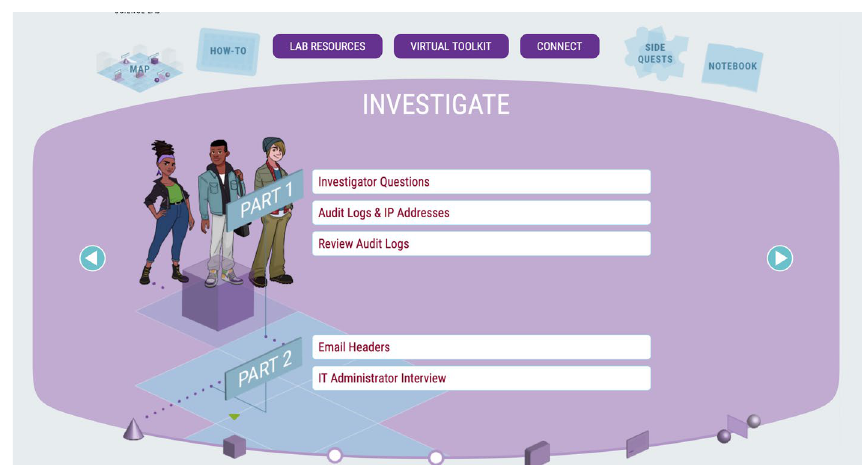
Fig. 2 The CSSL platform look-and-feel was updated after 2019 based on student focus group and survey feedback, shown here in Mission 3, which exhibits increased complexity for students to develop and apply what they learn in earlier